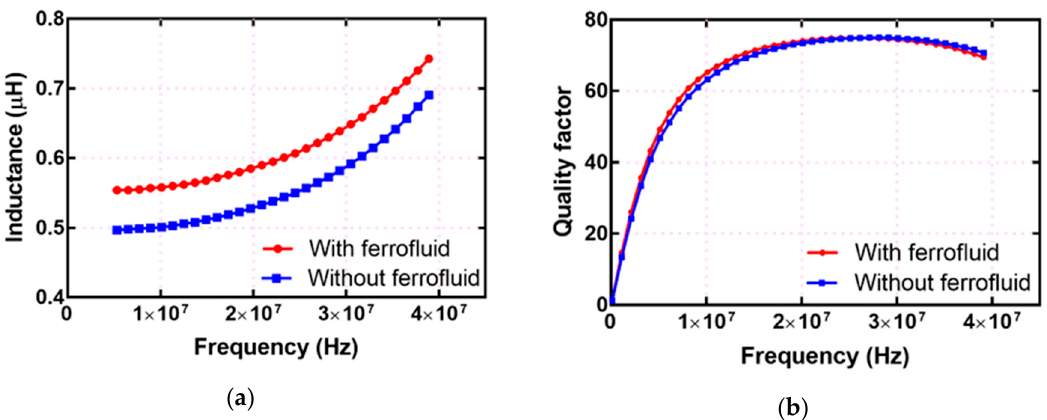
Figure 11. ( a ) Measured inductance, ( b ) measured quality factor, without and with ferrofluid inside the channel of microfluidic solenoid inductor.